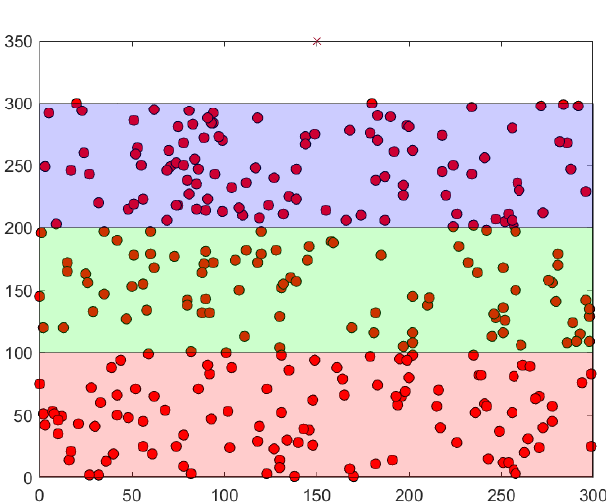
Figure 3. 300-Node model sample.